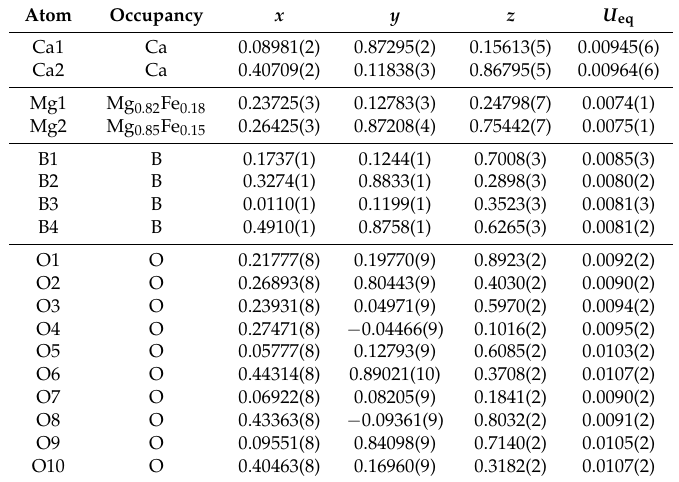
Table 4. Atomiccoordinates,siteoccupanciesandisotropicdisplacementparameters(Å 2 )forclinokurchatovite.